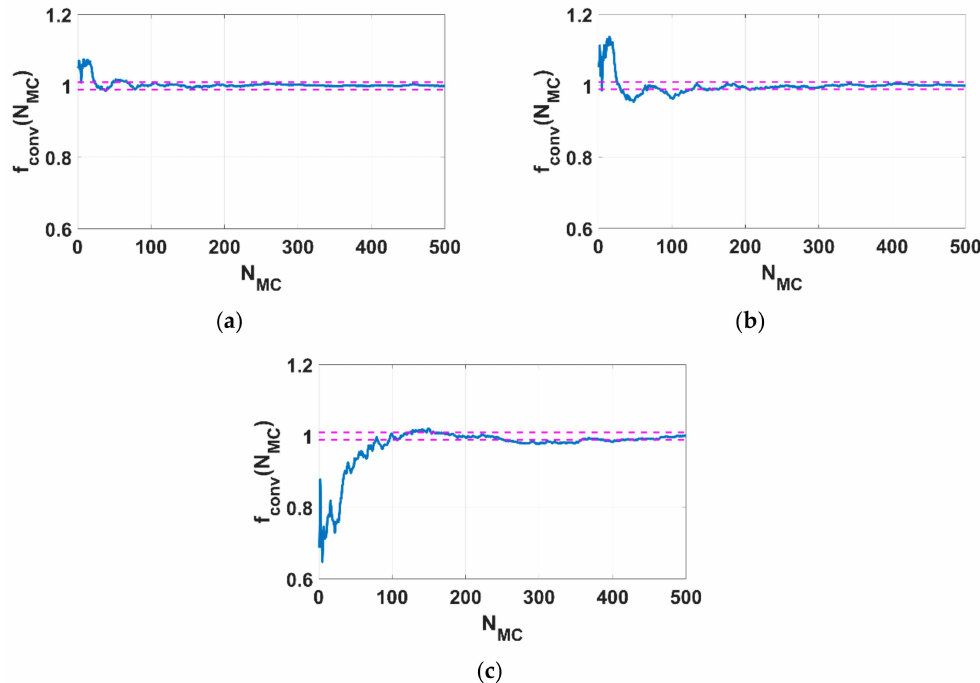
Figure 7. Convergence functions over 500 Monte Carlo simulations for ( a ) δ G = 0.3, ( b ) δ G = 0.5 and ( c ) δ G = 0.7. The discontinuous lines represent ± 1% deviation around the average value.